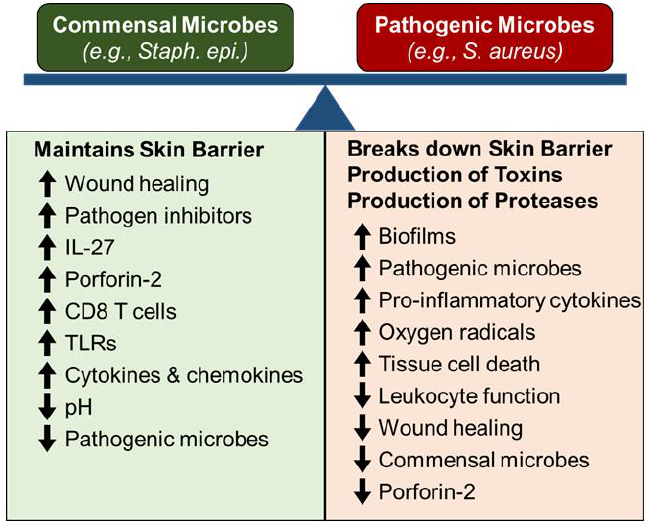
Figure 1. The skin microbiome balance and skin wound healing.